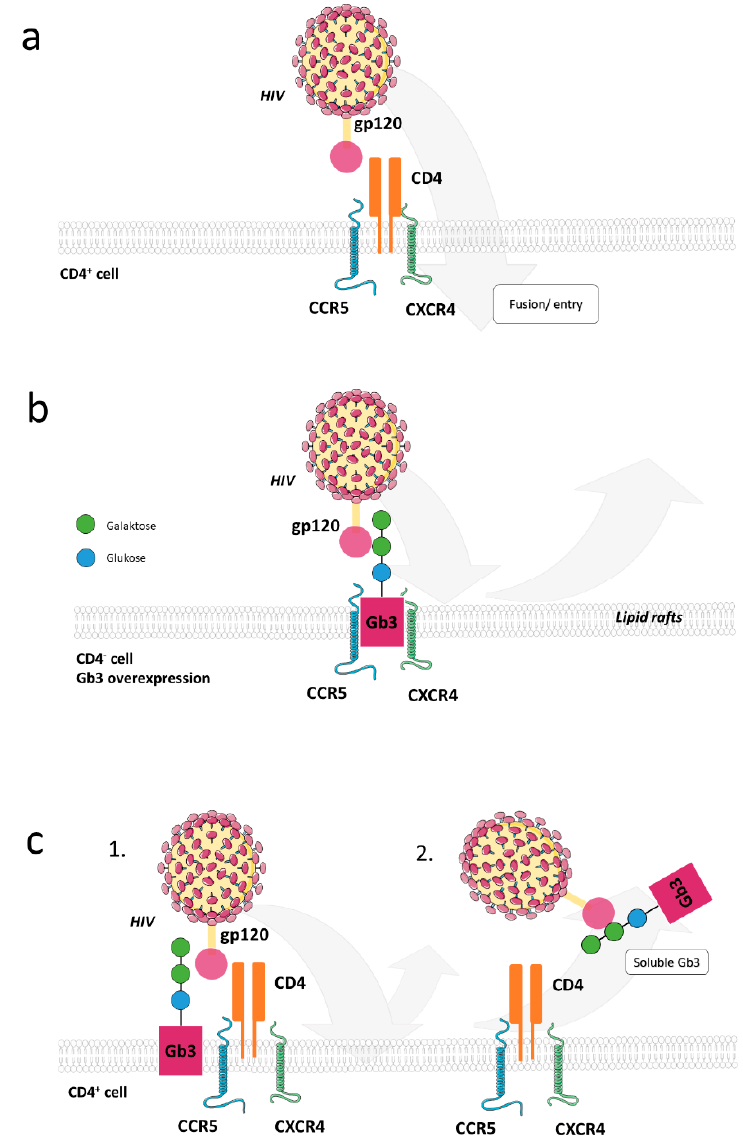
Figure 3. Schematic view of Gb3 interaction with HIV. ( a ) HIV infection requires gp120 binding to CD4. The associated conformational change of gp120 and simultaneous binding to chemokine co-receptors such as CXCR4 or CCR5 initiates cell fusion via gp41. ( b ) Gb3 overexpression in CD4- negative cells is associated with resistance to HIV infection as Gb3 is able to bind directly to gp120 and, consequently, block the chemokine binding motif. ( c ) Since T cells usually contain low levels of Gb3, HIV resistance is observed especially under conditions where Gb3 is overexpressed (1). In addition, soluble Gb3 analogues can bind to HIV gp120 and prevent binding to the CD4 receptor and the chemokine co-receptors, respectively (2).